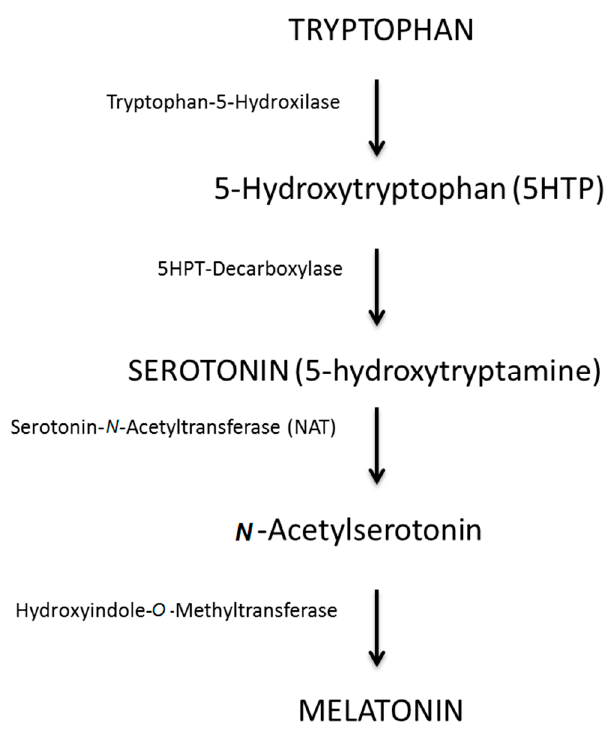
Figure 1. Melatonin synthesis and representation of its molecule (elaborated by the authors).